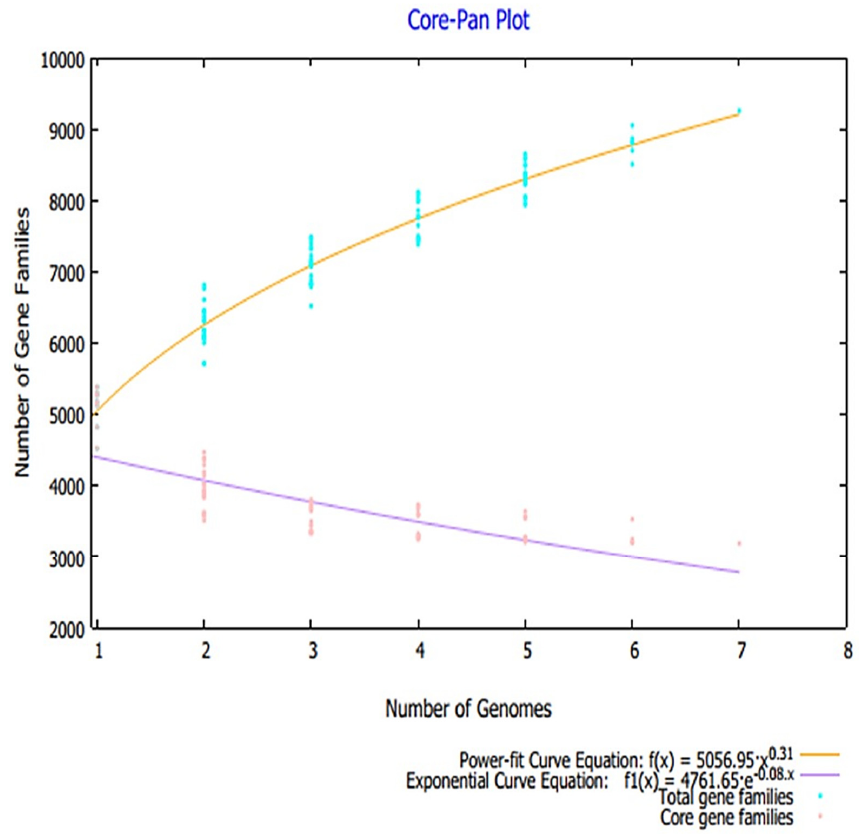
Figure 2. Core–pan plot obtained through pan-proteome